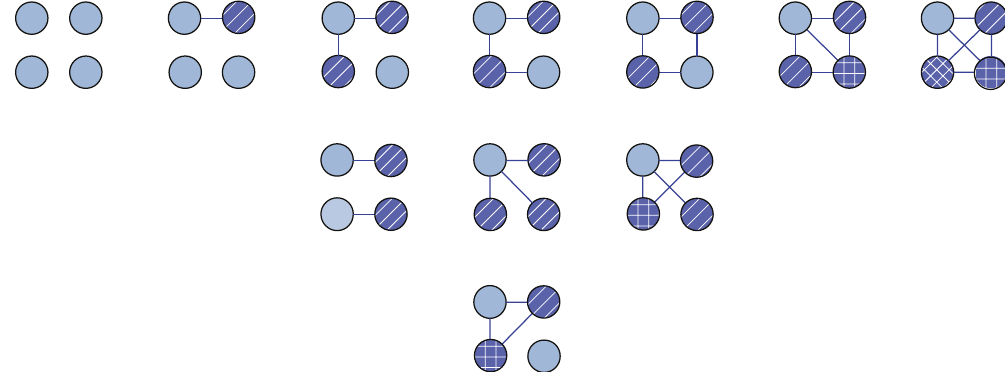
Figure 5: The eleven nonisomorphic graphs for a graph with 4 vertices.